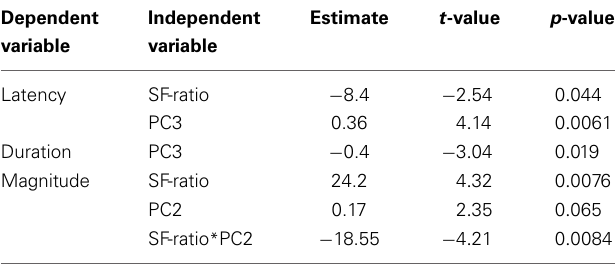
Table 1 | Relationships between vection measures, SF-ratio and PCs assessed by multiple regression